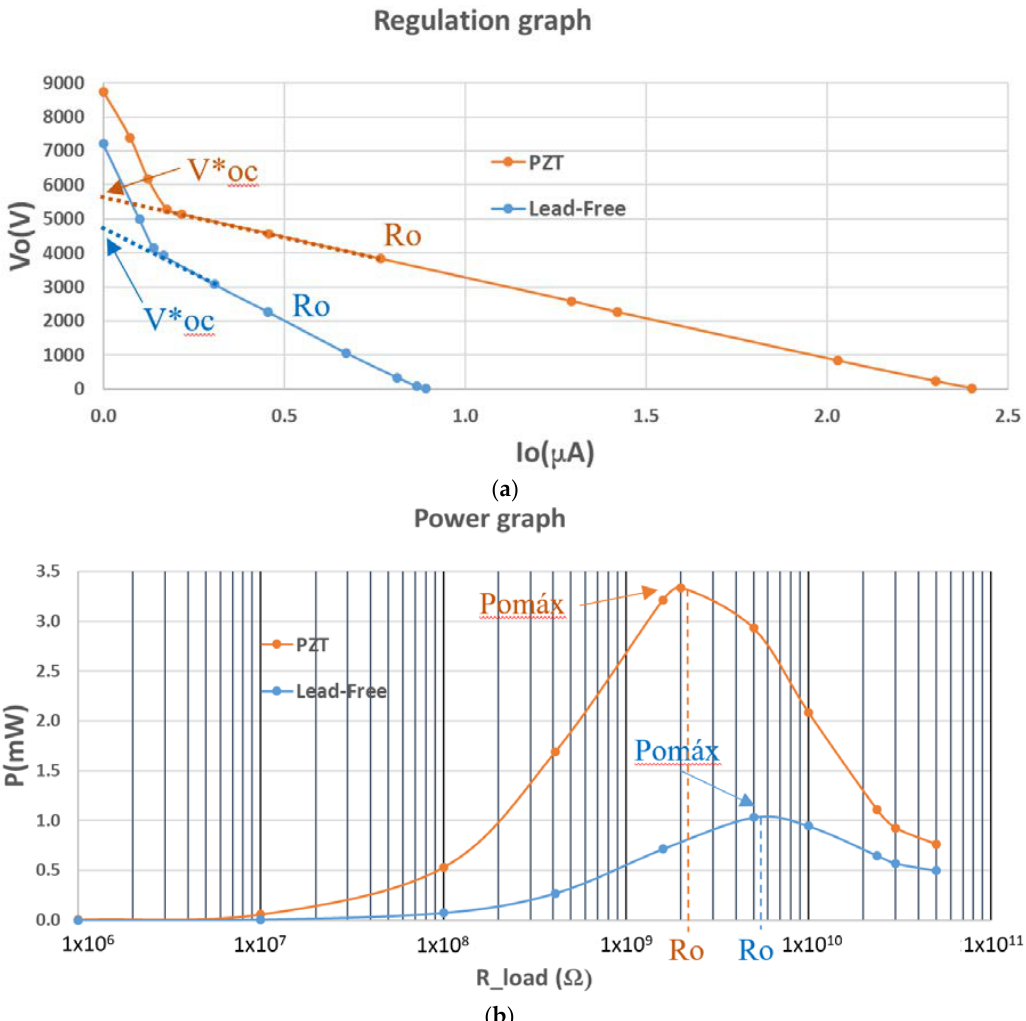
Figure 12. Comparative results: PZT vs. lead-free piezoceramics: ( a ) Regulation graph; ( b ) power generated graph.